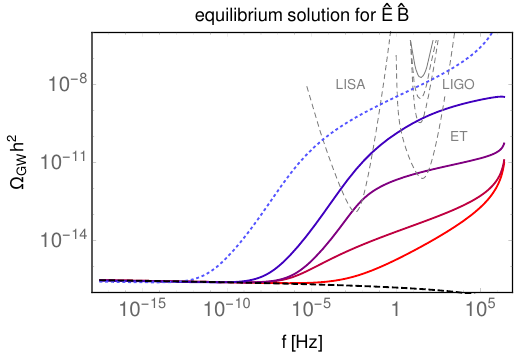
Figure 9 . Predicted gravitational wave spectra for di(cid:11)erent fermion masses, employing the equi- librium solution. The (dashed) gray lines indicate the power-law sensitivity curves of the (future) gravitational wave interferometers LIGO, LISA and the Einstein Telescope. Color coding as in (cid:12)gure 6. For reference, the dashed black line indicates the vacuum contribution and the dotted blue line indicated the predicted spectrum in the absence of